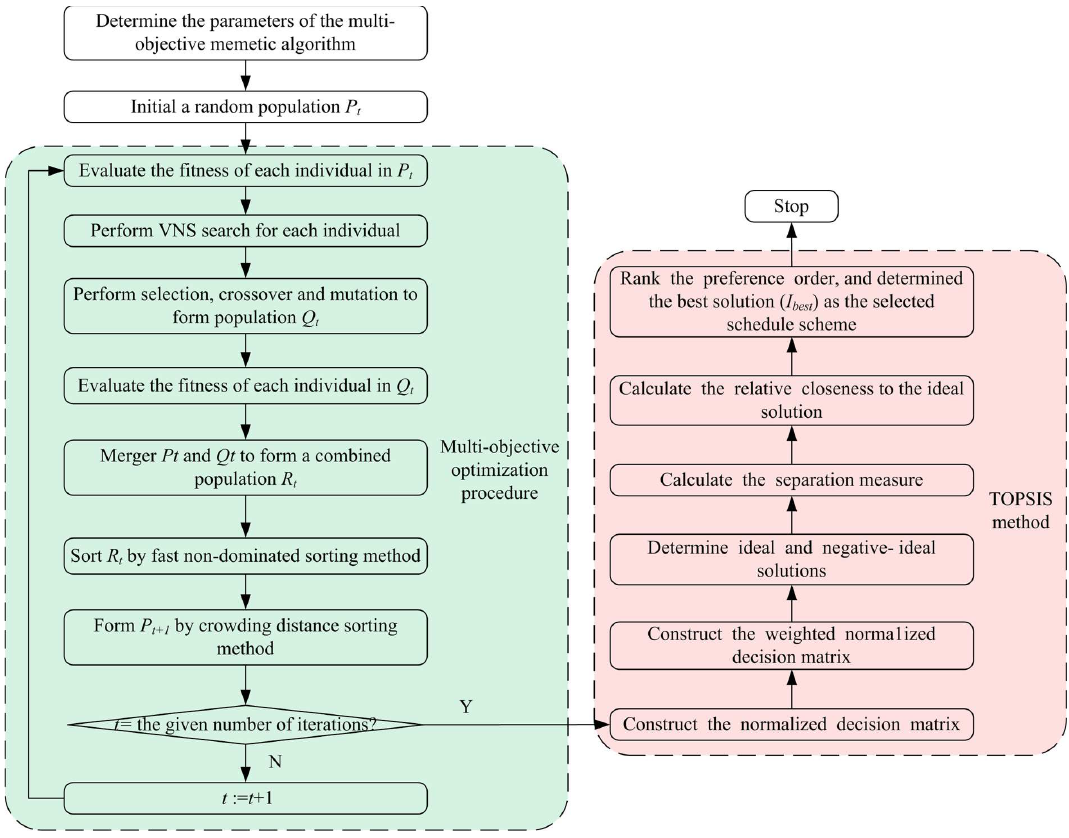
Figure 3. The work flow of the proposed